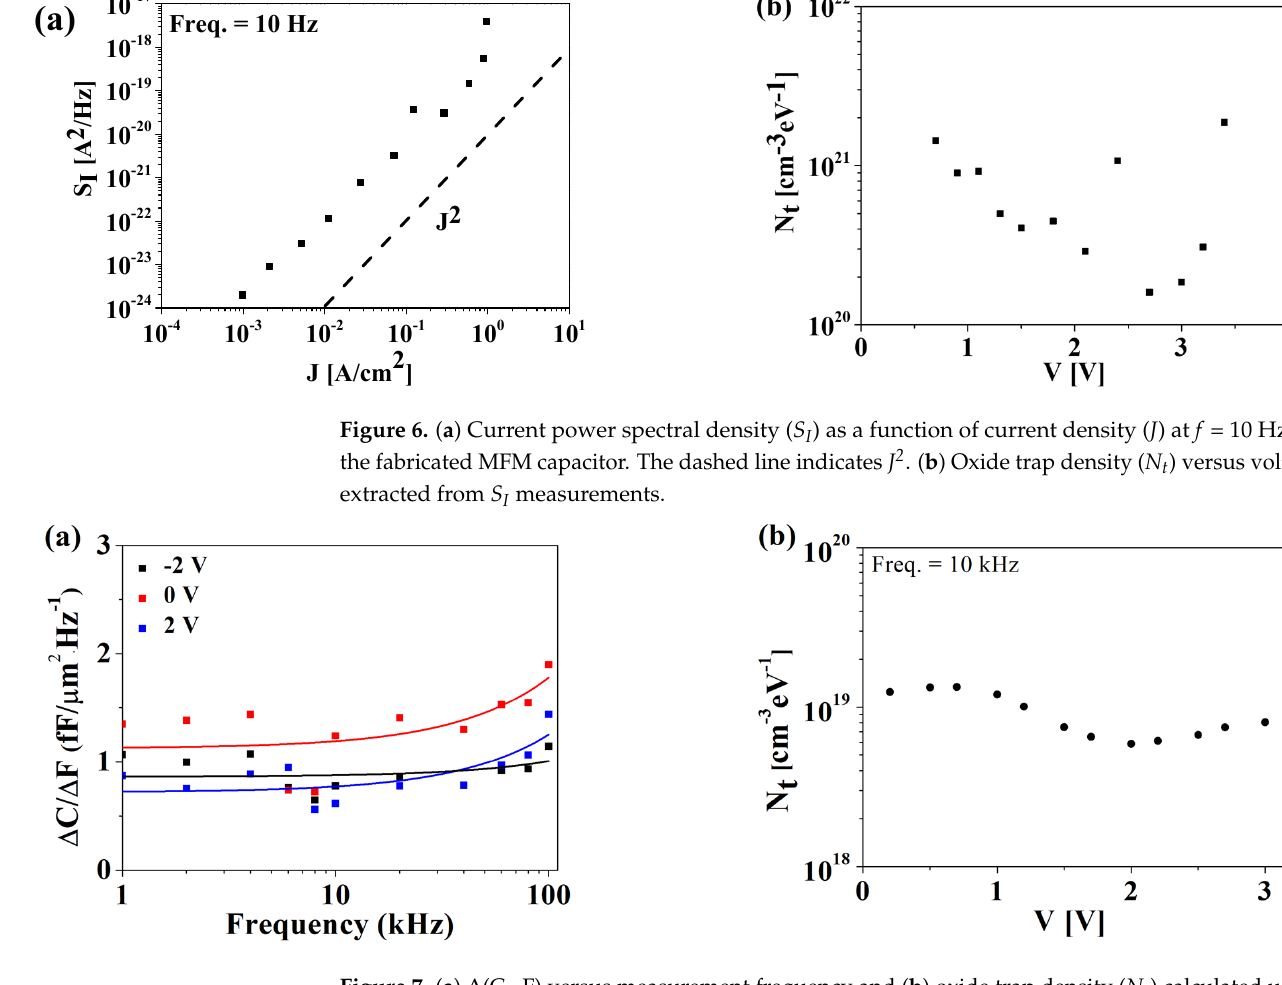
Figure 7. ( a ) ∆ (C (cid:3398) F) versus measurement frequency and ( b ) oxide trap density ( N t ) calculated using the ∆ (C (cid:3398) F slope) method and measured at 10 kHz.